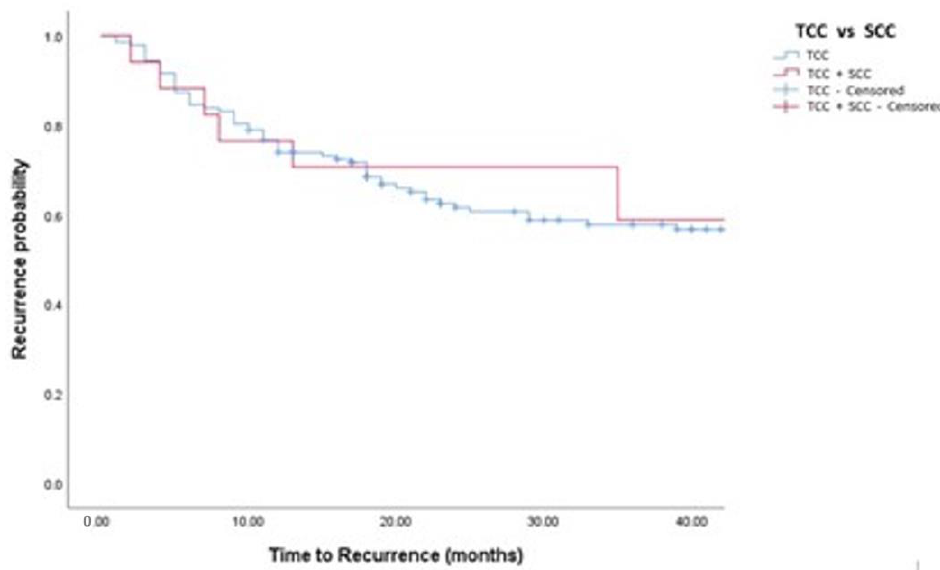
Figure 2. Kaplan–Meier analysis showing estimates of disease recurrence in in TCC and TCC + SCC patients treated with BCG (log-rank p = 0.532).